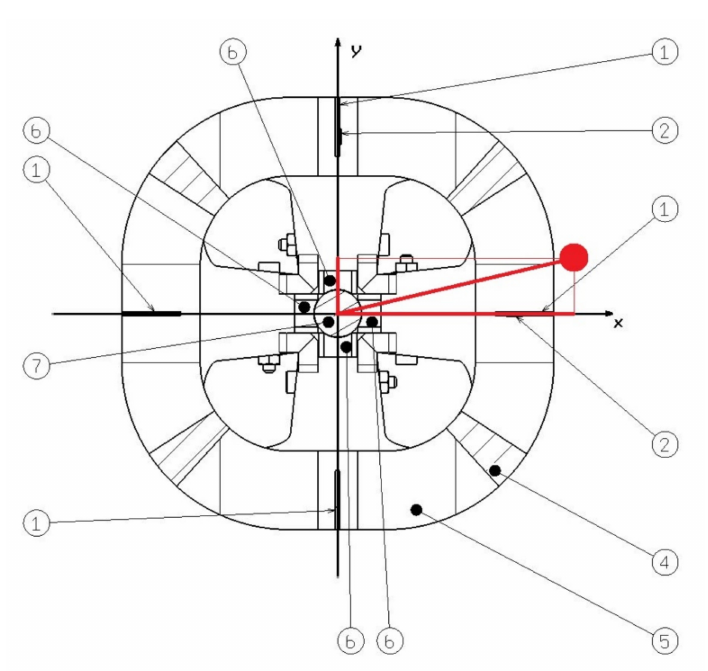
Figure 2. Top view of the device in section through flexible elements (the description of the compo- nents is the same as Figure